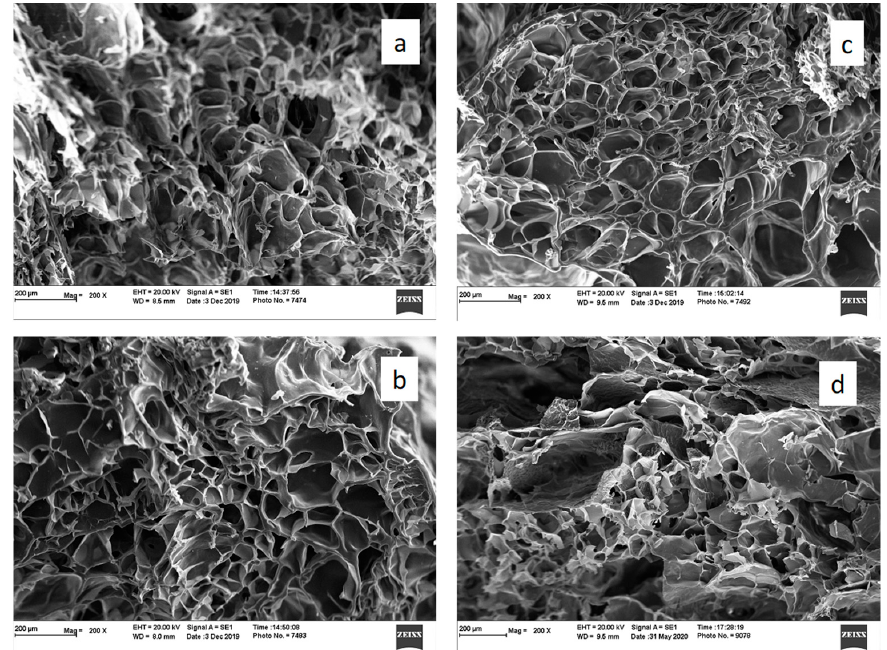
Figure 3. SEM image of ( a ) P4G21%, ( b ) P6G21%, ( c ) P8G21% and ( d ) P8C40% DN hydrogels.